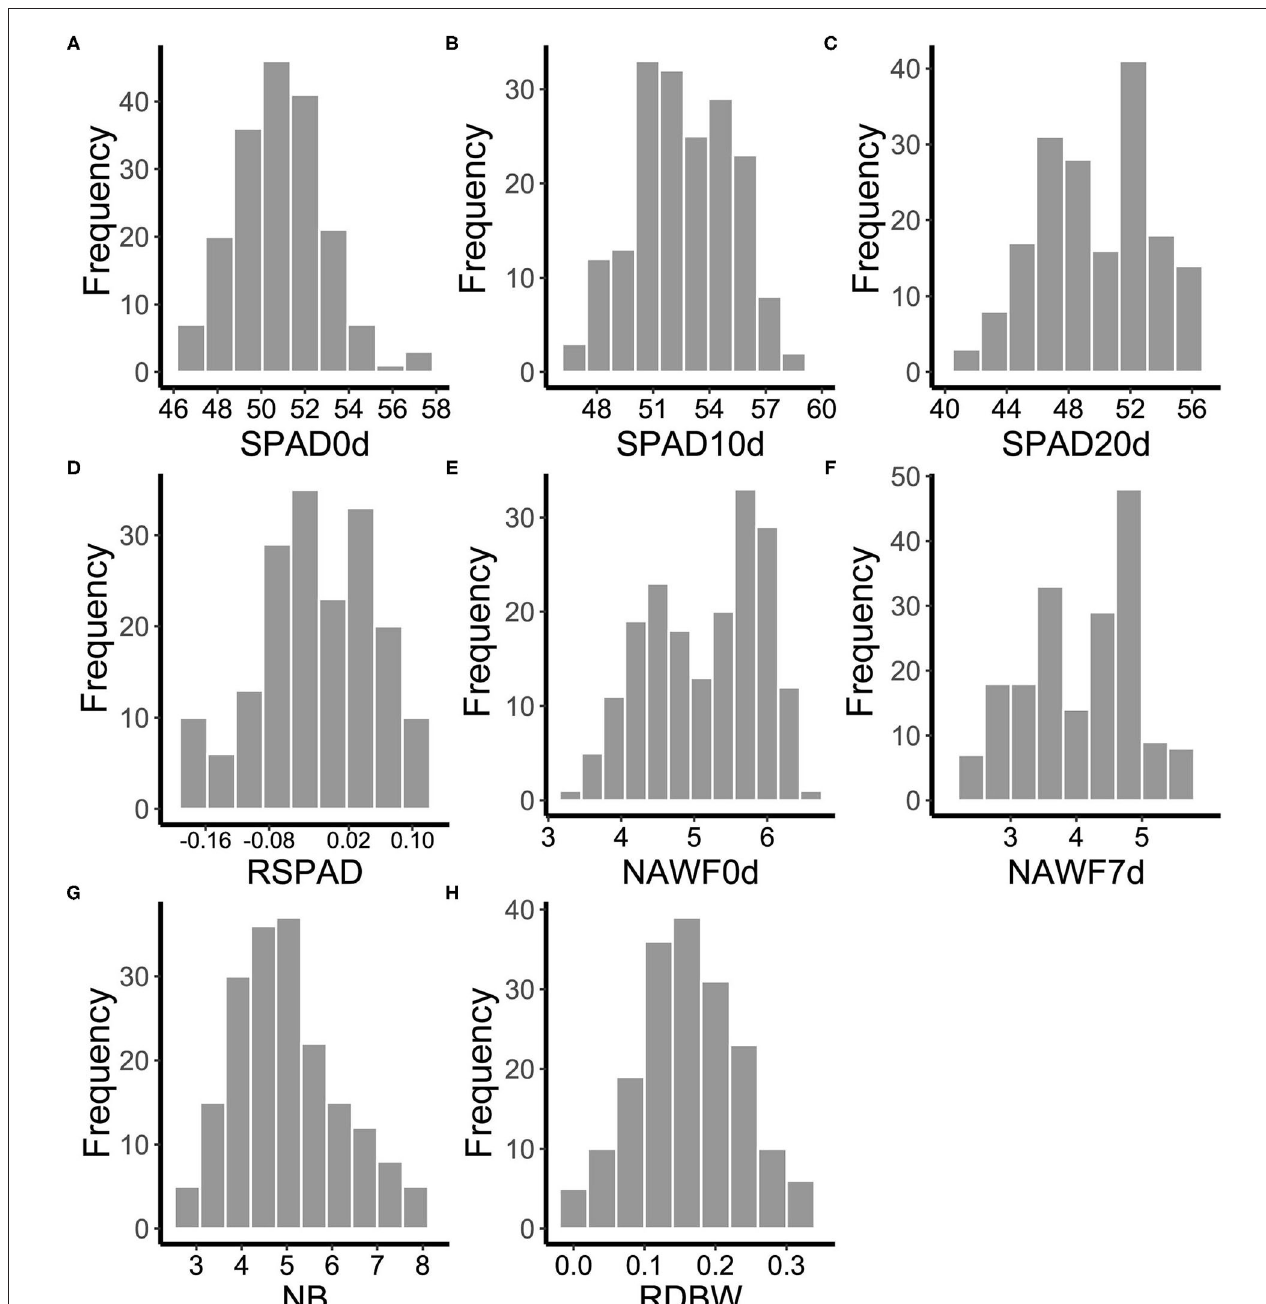
FIGURE 1 | Frequency distributions of the mean values of eight senescence-related traits for 185 cotton accessions in multi-environments. (A) SPAD0d: SPAD value on topping day. (B) SPAD10d: SPAD value 10 days after topping. (C) SPAD20d: SPAD value 20 days after topping. (D) RSPAD: relative difference of SPAD. (E) NAWF0d: nodes above white flower on topping day. (F) NAWF7d: nodes above white flower 7 days after topping. (G) NB, number of open bolls on the upper four branches. (H) RDBW, relative difference of boll weight.